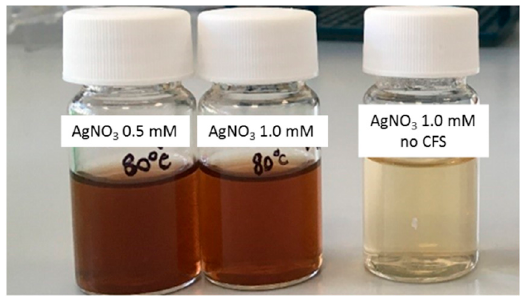
Figure 1. AgNP formation by the SAMU strain. The reduction of silver nitrate, evidenced by color change of the reaction mixture from light to dark brown, is indicative of NP production. For comparison, on the right, a nitrate solution without CFS is shown.